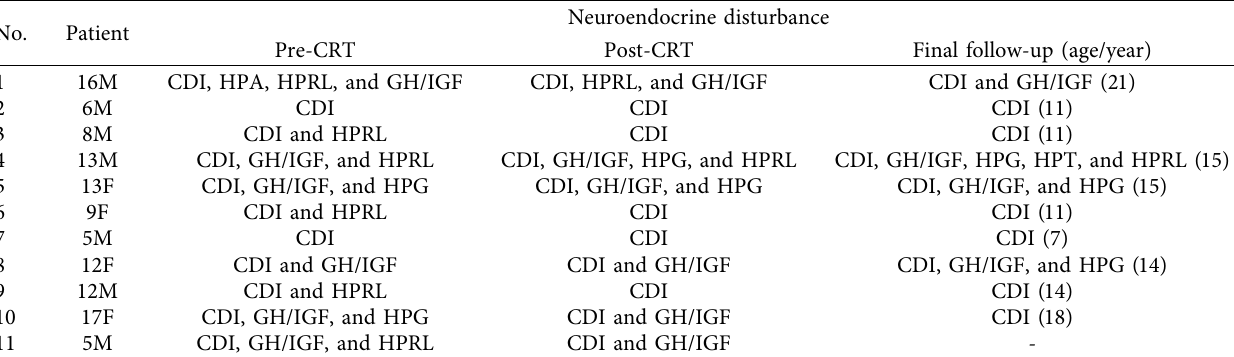
Table 2). Three patients with hyperprolactinemia at diag- nosis spontaneously normalized, and two remained elevated. For two patients with hypogonadotropic hypogonadism